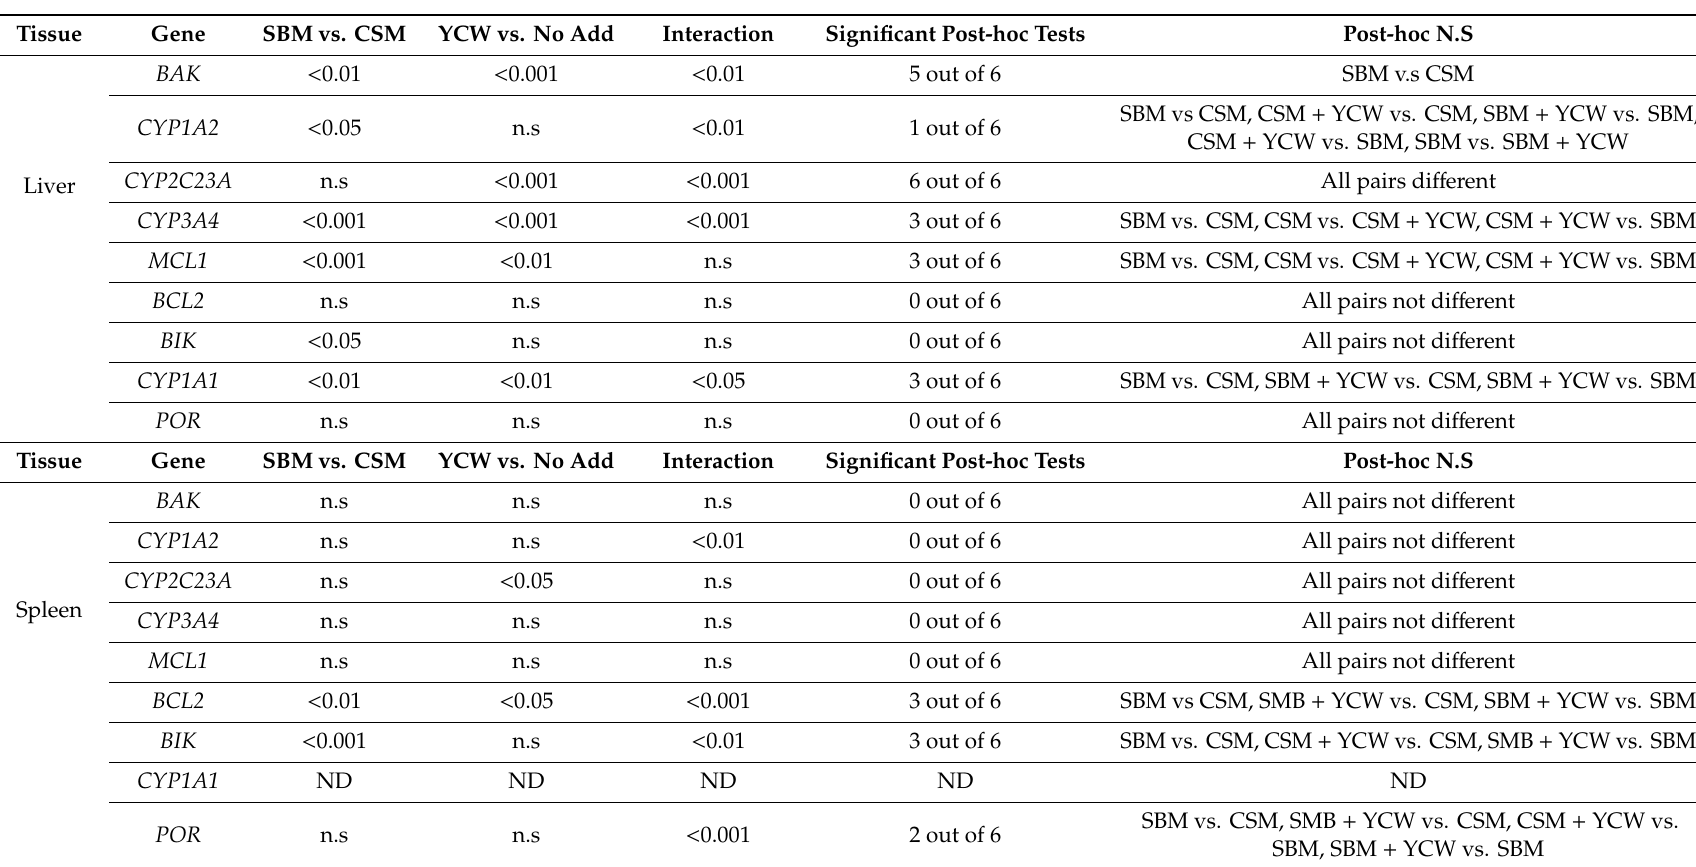
Table 4. Summary of 2-Way ANOVA results based on two main variables—dietary protein (SBM vs. CSM) and prebiotic inclusion (YCW vs. no additive), and the interaction term. In addition, presented are the summary of post-hoc pairwise analyses using the Tukey Honest Significance (HSD). The count of significant pairwise comparisons are given in column six, and the non-significant results of pairwise comparisons are listed in the Post-hoc N.S